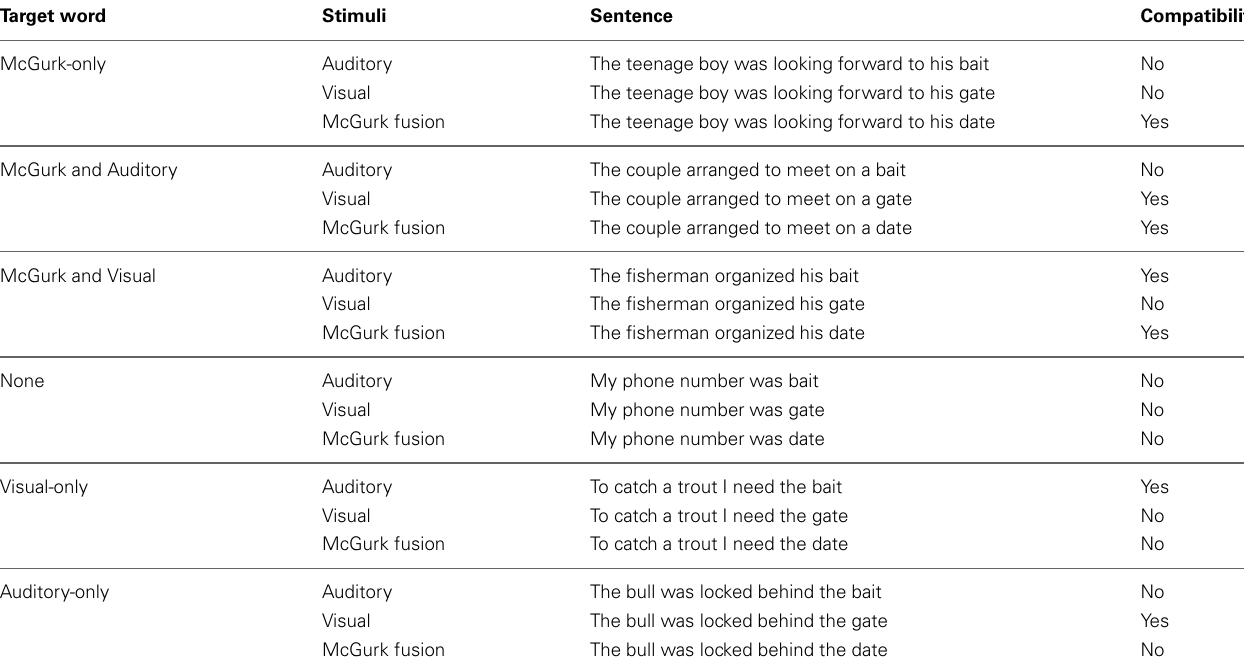
Table 2 | Example of manipulation of sentence meaning for the audio-visual combination of |bait|and [gate] perceived as “date.” Target